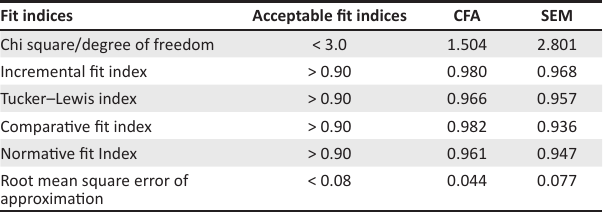
TABLE 3: Model fit